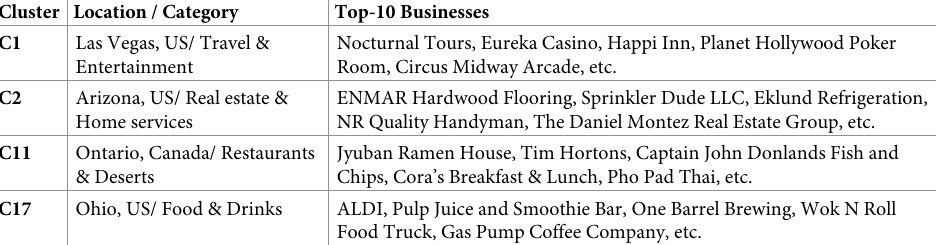
Table 5. Clustering results on business factor U (2) found by S 3 CMTF. We found dominant spatial and categorical characteristics from each cluster. Businesses in a same cluster tend to be in adjacent cities and are included in similar